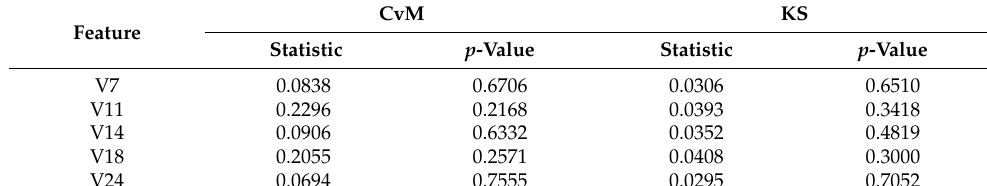
Table 7. Kolmogorov–Smirnov and Cramér–von Mises tests for the MPoW model.